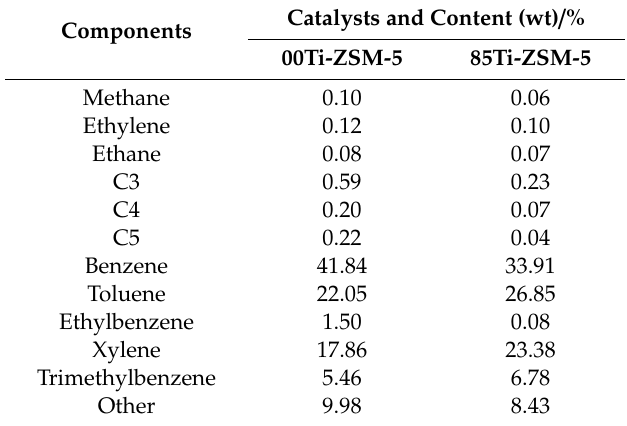
Table 4. Products distribution of hierarchical 00Ti-ZSM-5 and hierarchical 85Ti-ZSM-5 in benzene alkylation with methanol.